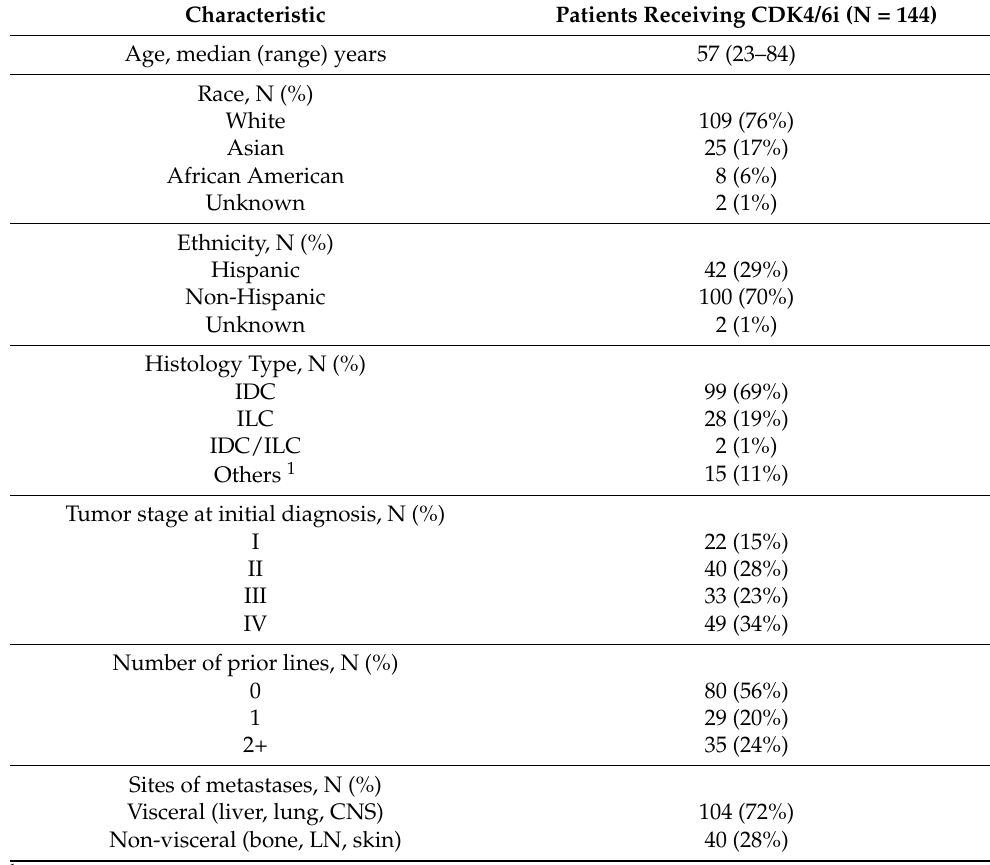
Table 1. Patient characteristics and treatment